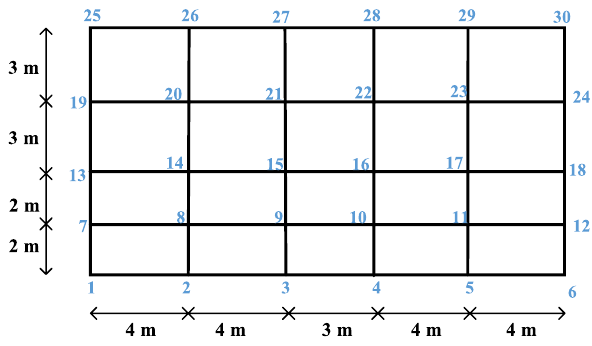
Fig. 22 Meshed domain with 20 elements for the fifth k = k = ( k − k ) sin 𝛼 cos 𝛼 . That, k xy yx 1 2 and minor permeability coefficient, respectively.